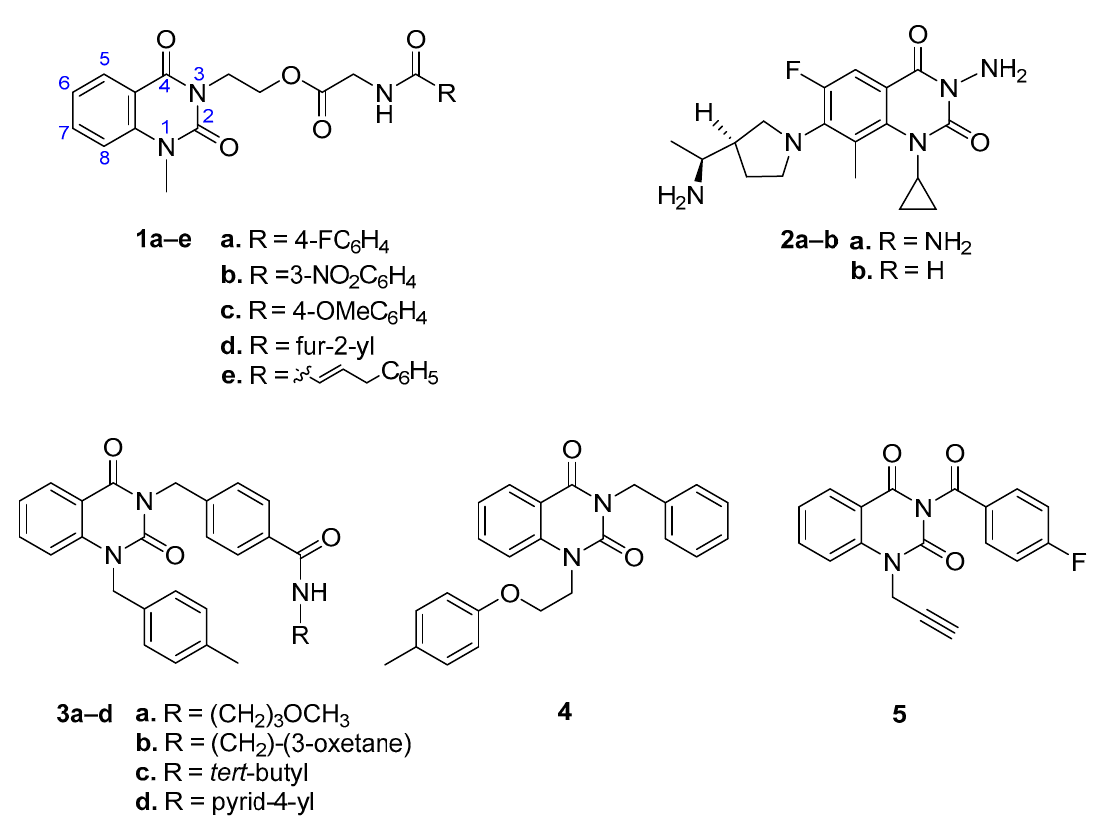
Molecules 2022 , 27 , x FOR PEER REVIEW Figure 1. Examples of quinazoline-2,4-dione derivatives showing antibacterial and antiviral activity. Compounds with promising antiviral activity have been found as nucleoside and nucleotide analogues (Figure 2). For instance, 1,2,3-triazoles 6a–b [13] and their phospho- nylated analogues 7–8 [1,14] functionalized with quinazoline-2,4-dione moiety, both de- signed as acyclic nucleoside analogues, appeared to be active against herpes simplex vi- ruses (HSV-1 and HSV-2) (EC 50 values in the range of 2.9–17 µM, 4–11 µM towards HSV- 1 and HSV-2, respectively) [1,13,14]. Additionally, compound 6a inhibited the replication of varicella-zoster virus (VZV) at EC 50 = 6.8–8.2, while derivatives 7 and 8 were also active toward feline herpes viruses (EC 50 = 4, 24 µM for 7 and 8 , respectively) [1,13,14]. Quinazo- line-2,4-dione-containing nucleosides 9a–b showed antiviral activity against influenza vi- rus (H1N1) (IC 50 = 30–42 µM) [15].